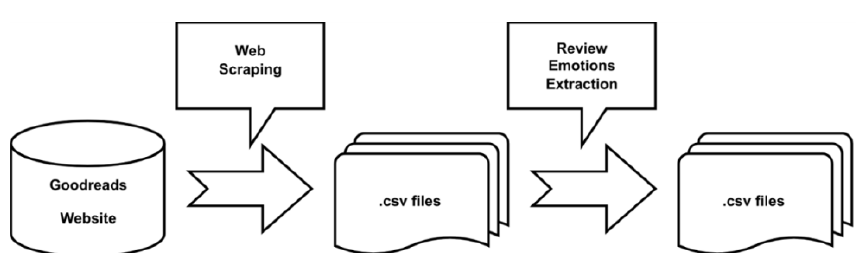
Figure 1. System